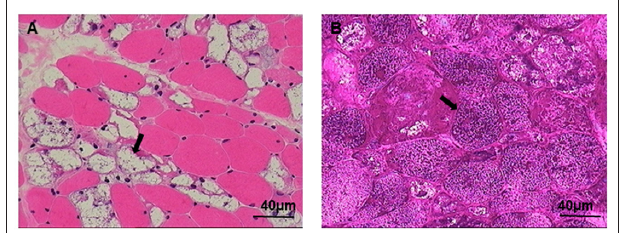
FIGURE 1 | Muscle biopsy is shown using the Hematoxylin and Eosin (HE) and periodic acid-Schiff (PAS) staining. (A) Large numbers of glycogen-containing vacuoles were found in the muscle fibers (arrow). (B) Vacuoles were PAS positive stained (arrow), scale bar: 40 µ m.